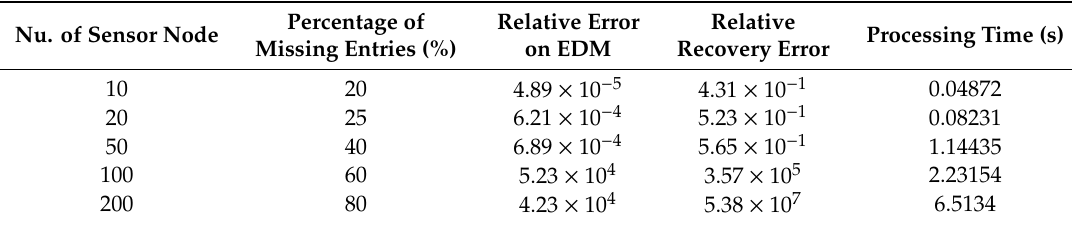
Table 1. Experimental results for 2-dimensional Wireless Sensor Network localization via Semidefinite Programming (CVX Toolbox).